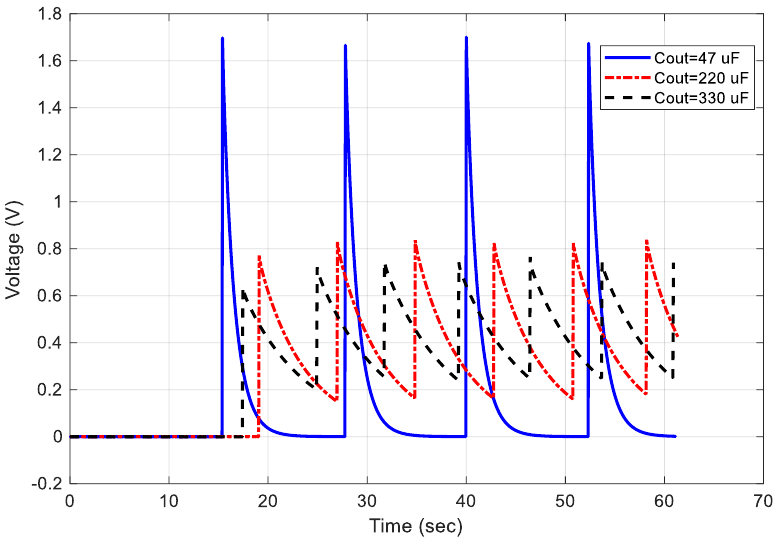
Figure 10. The output voltage of LTC3588 versus time for different values of C out , when LTC3588 is connected to the external load R load = 20 k Ω; Cin = 22 μ F; and f = 2.88 Hz.